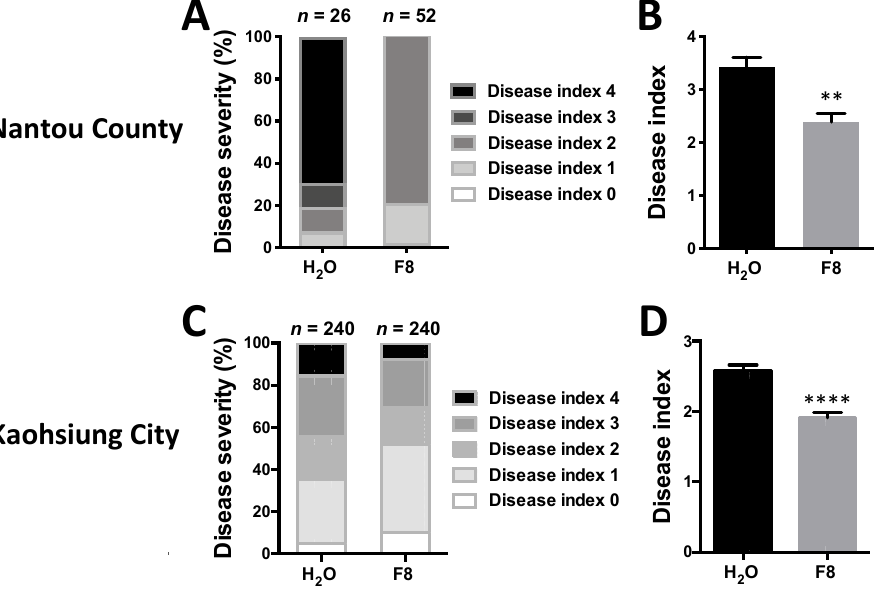
Figure 6. Symptoms on H 2 O or F8-culture filtrate treated tomato in the field in Nantou County and Kaohsiung City. Tomato seeds were sown and grown in a growth chamber for 3 weeks. Yu-Nu tomato and Xiao-Nu tomatoes were pretreated with H 2 O or F8 by spraying three times with a 24-h interval between each spray, then transplanted to fields in Yuchi Township, Nantou County, or Alian Dist., Kaohsiung City. The level of disease index was recorded at 2-months post transplantation ( A , C ). The average of the disease index ( B , D ). Data represent mean ± SEM. Student’s t -test was used for analysis of the data in the F8-culture filtrate pretreated group and the H 2 O-pretreated control group. ** p < 0.01; **** p < 0.001.